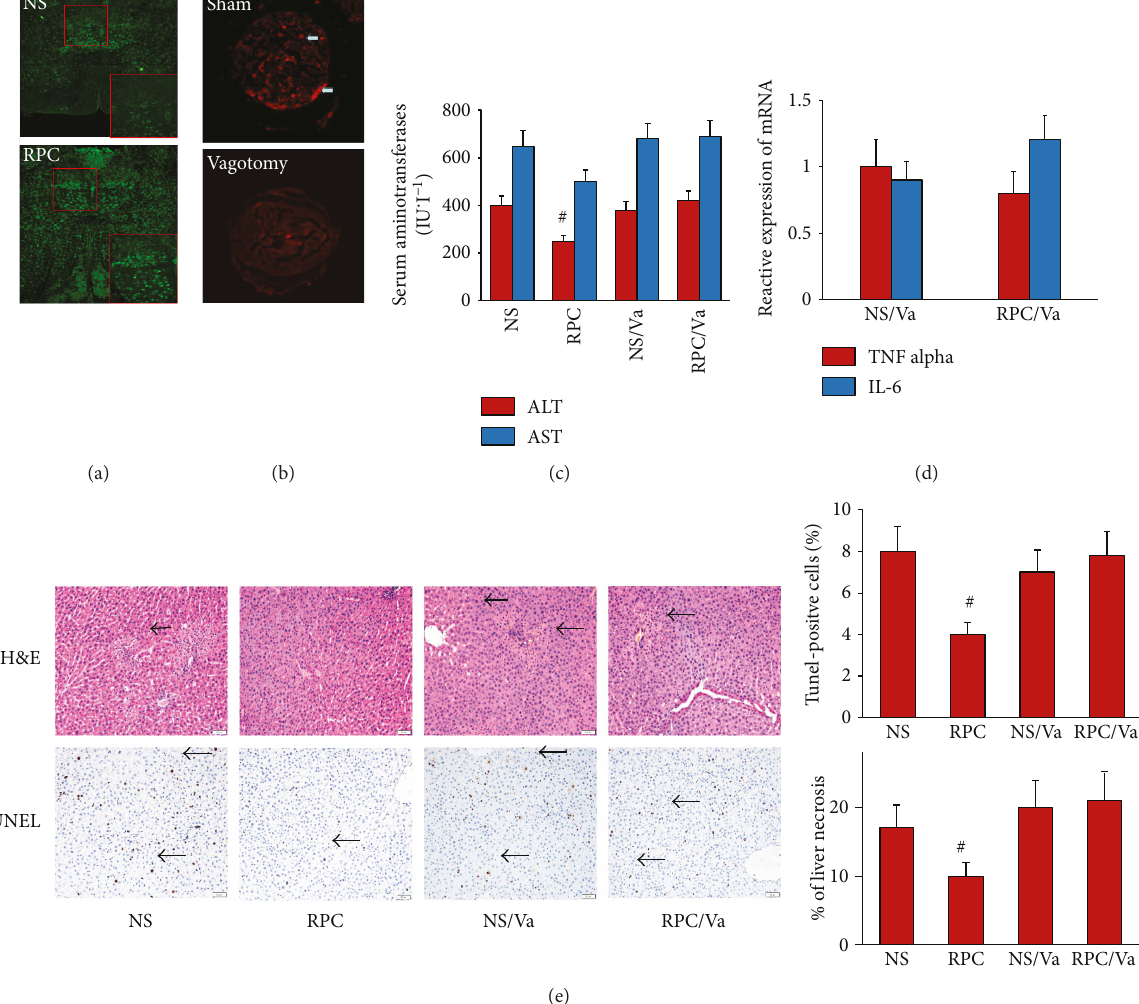
Figure 3: Hepatic protective e ff ect of opiate agonist disappeared after vagotomy. Rats were divided into 4 groups with or without vagotomy and then treated with an intravenous injection of remifentanil (2 μ g · kg − 1 · min − 1 ) or normal saline (NS) within 15 minutes. Hepatic IR was induced 10minutes after the treatment above with ischemia for 45 minutes and 120-minute reperfusion. n = 8 in each group. (a) Activation of neuron was manifested by c-Fos immuno fl uorescence. Red frame regions revealed that remifentanil preconditioning (RPC) activated DMV compared with the NS group. (b) Fluorescent Dil tracer indicated that the communication of the vagus nerve between the liver and the inferior ganglion of the vagus nerve in the vagotomized group was almost interdicted, so that the operation of vatogomy was reliable. (c) Serum alanine aminotransferase (ALT) was signi fi cantly lower in the RPC group than in the NS group and vagotomy groups. ( # P < 0 05 versus NS, NS/Va, and RPC/Va groups). (d) There was no statistical signi fi cance in relative mRNA expression of TNF- α and IL-6 from quantitative real-time PCR between the NS/Va and RPC/Va groups. (e) Photograph depicts a typical pattern of focal necrosis after ischemic insult. Black arrows indicate ischemic changes that were seen less seriously in the remifentanil preconditioning (RPC) group compared with the other groups. The degree of apoptosis and the number of terminal deoxynucleotide transferase-mediated deoxyuridine triphosphate nick-end labeling- (TUNEL-) positive cells (black arrows) were also decreased in the remifentanil preconditioning (RPC) group (magni fi cation: 200x; # P < 0 05 versus NS, NS/Va, and RPC/Va